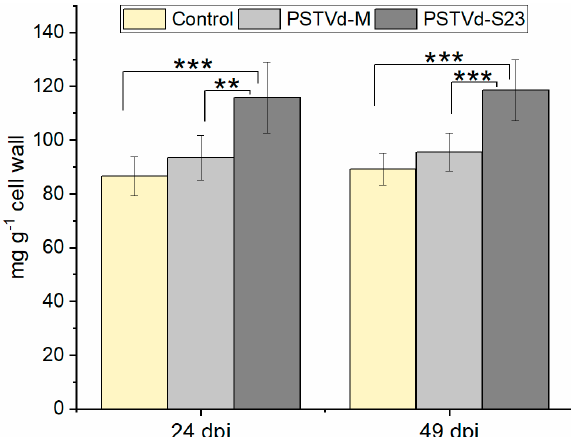
Figure 6. Lignin content in roots at 24 and 49 dpi. One-way analysis of variance, followed by Tukey’s honest significant difference test, was performed to determine the significance of the differences; ** p < 0.01, *** p < 0.001. Each bar represents the arithmetic mean of the lignin amount from three roots with the standard deviation indicated.